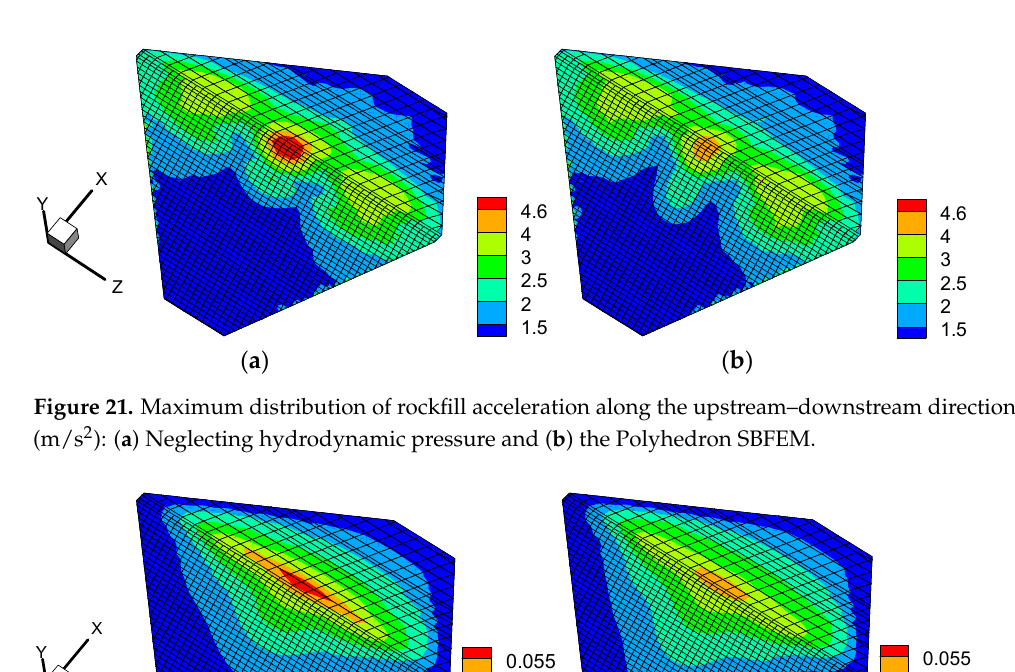
Water 2022 , 14 , x FOR PEER REVIEW